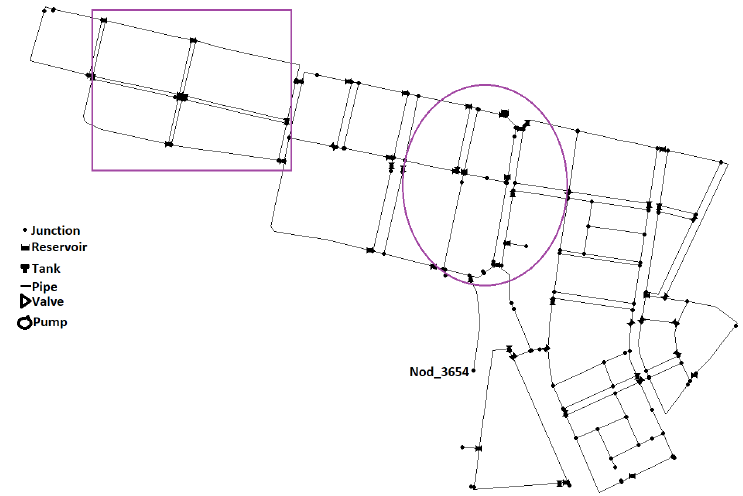
Figure 1. Water distributed networks from Madrid (city center).